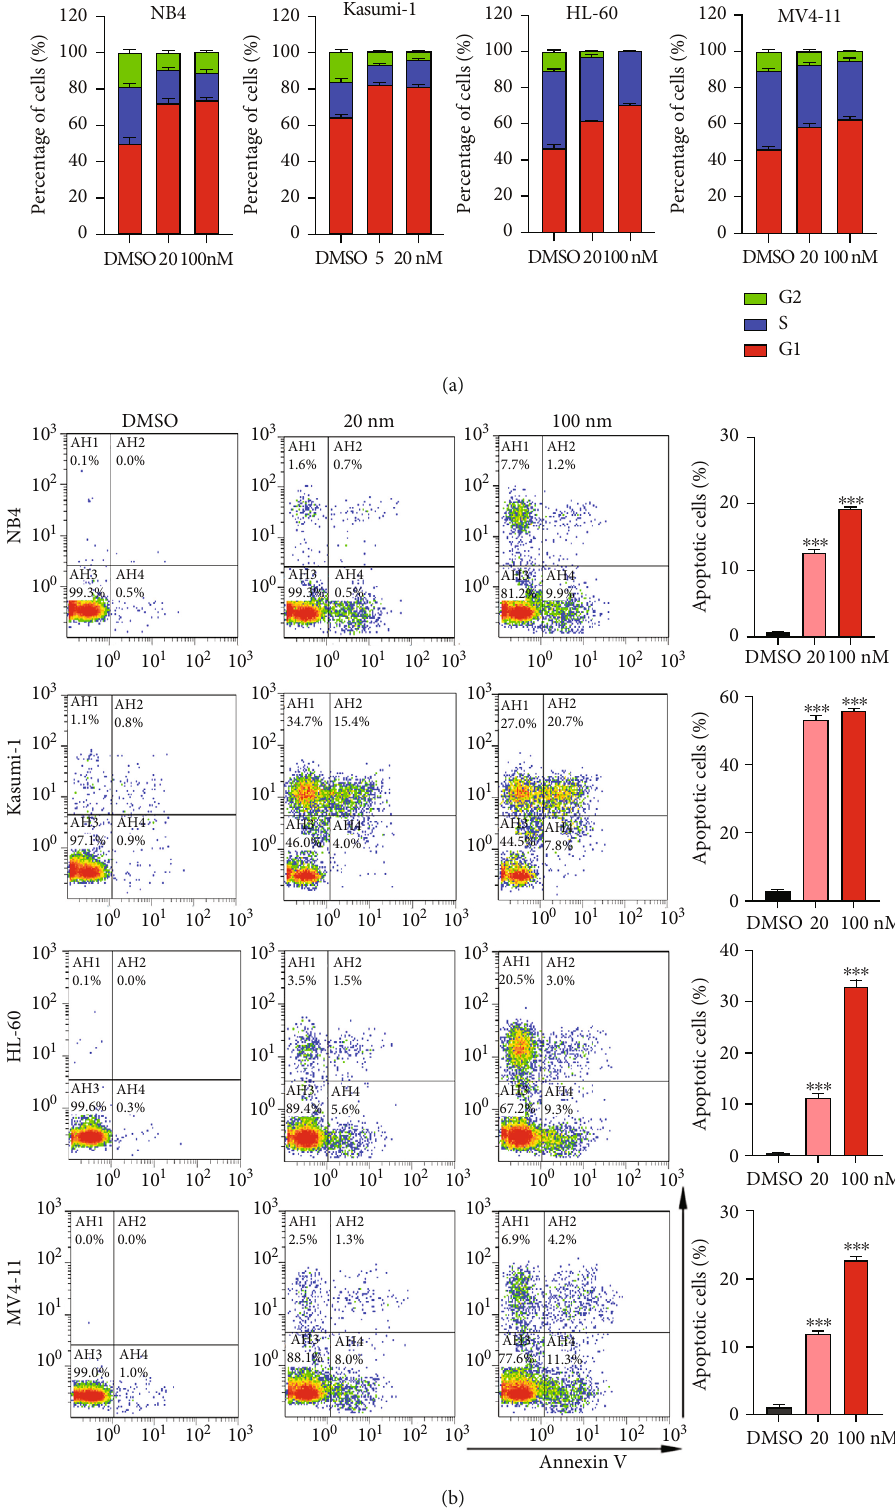
Figure 3: GNE-987 blocked the cell cycle and promoted the apoptosis of AML cell lines. (a) PI-labeled cell cycles of NB4, Kasumi-1, HL-60, and MV4-11 cells were analyzed after treatment with DMSO or di ff erent concentrations of GNE-987 for 24 h. AML cells were distributed in the G1/S phase, and the cell population in the G1 phase increased dramatically after treatment with GNE-987. (b) Annexin V and PI-labeled cell apoptosis of AML cells were analyzed by fl ow cytometry after treatment with DMSO or di ff erent concentrations of GNE-987 treatment for 24h. The apoptotic rates of AML cells were signi fi cantly increased after GNE-987